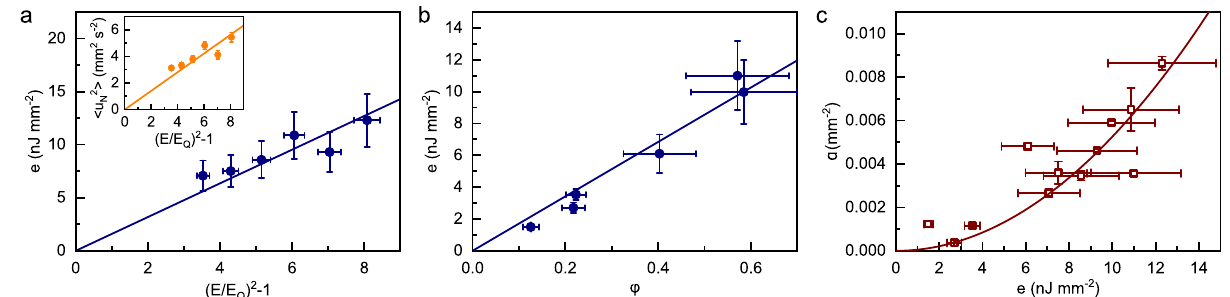
Fig. 4 Activity enhances droplet shape fl uctuations. a The energy per area, e , dependence on electric fi eld E , ð E = E Q Þ 2 (cid:3) 1, with E Q = 1.50 ± 0.03 MV m − 1 . i on ð E = E Þ 2 (cid:3) 1. In both cases the line is a least squares fi t to the experimental Inset: Linear dependence of the square average of velocity fl uctuations h u 2 Q N points. All experiments were performed on the same droplet with packing fraction φ = 0.58 ± 0.11 and droplet area A drop = 11.05 ± 0.03 mm 2 . b As predicted by Eq. (2), the energy density e is linearly dependent on φ . The line is a least squares fi t to the experimental points. These experiments were performed at the same E = 4.25 ± 0.01 MV m − 1 but different droplets with A drop in the range from 8.97 mm 2 to 11.25 mm 2 . c A graph of the